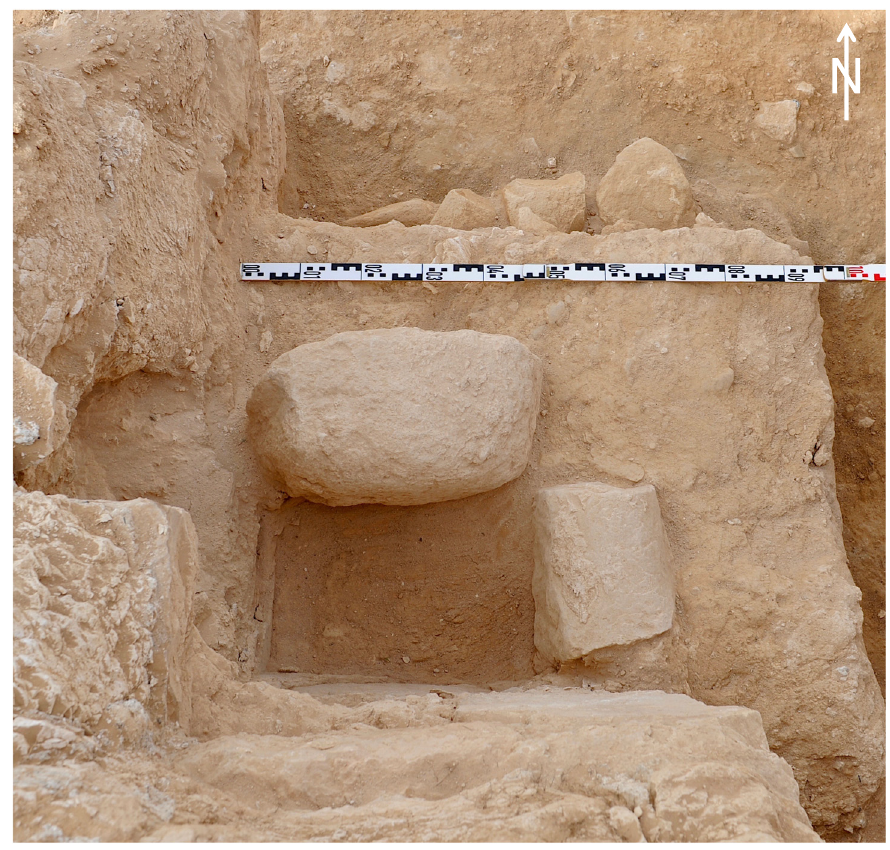
Figure 4: Field photographic documentation of Structure no 1 ( Pièce 4 ) after excavation. Photograph by Vigouroux ( 2015 )